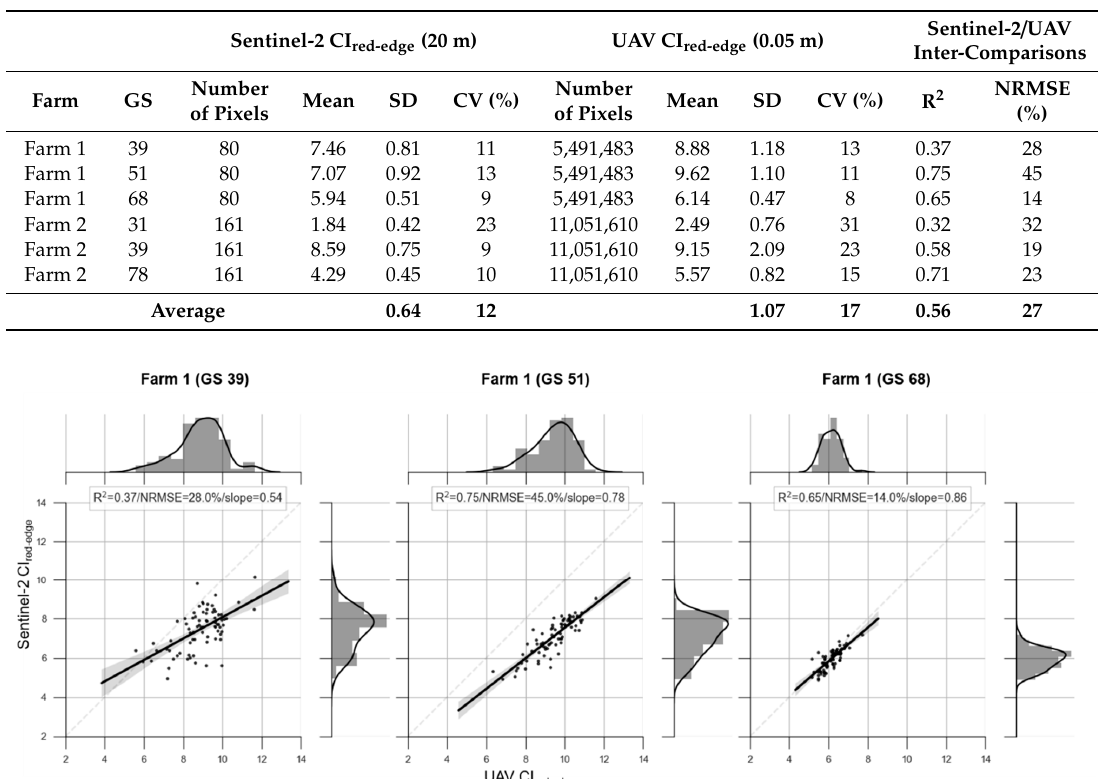
Table 2. Summary statistics for CI red-edge , derived from samples extracted from a Sentinel-2 20-m pixel grid, quantifying multi-temporal di ff erences between coarse-scale Sentinel-2 and fine-scale resolution UAV values averaged per Sentinel-2 grid cell. Metrics, reported per farm and growth stage (GS), include number of pixels sampled, mean value, standard deviation (SD) and coe ffi cient of variation (CV), coe ffi cient of determination (R 2 ) and normalised-root-mean-square error (NRMSE).